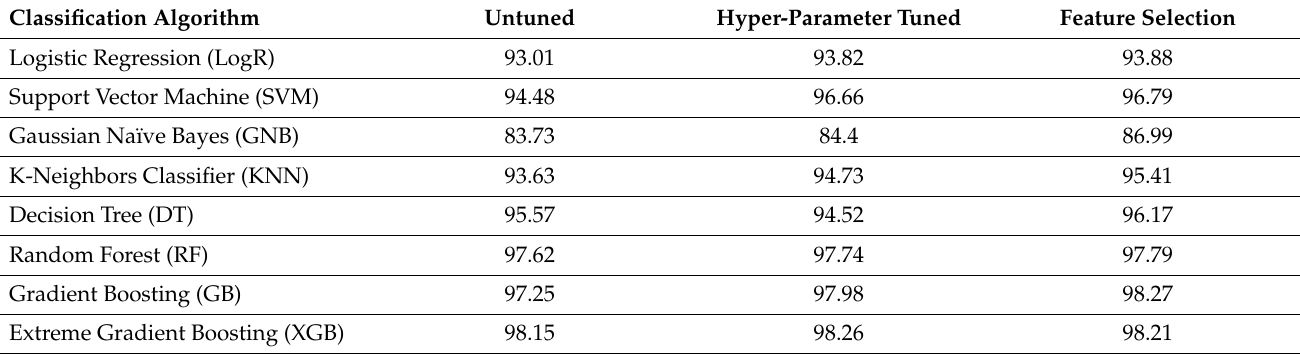
Table 17. Dataset-2 performance (accuracy %)